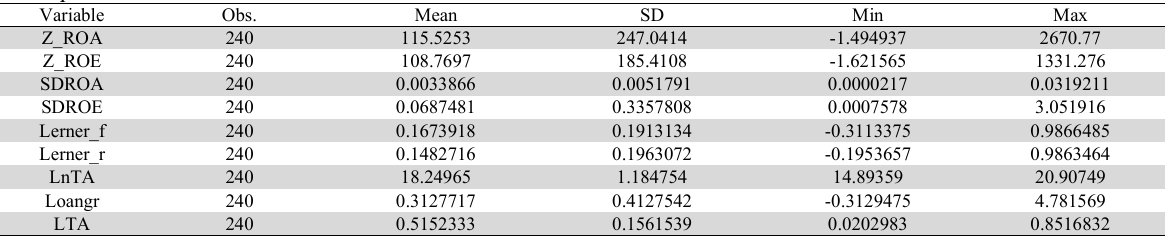
Descriptive statistics of variables